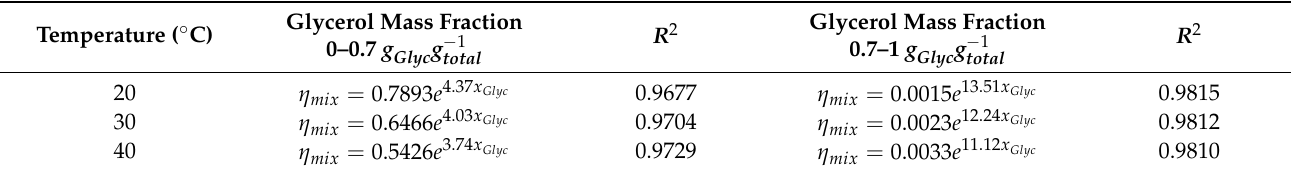
Table 2 resumes the equations for viscosity calculation for the three temperatures. Table 2. Equations for imaging analysis of viscosity at 20, 30, and 40 °C.